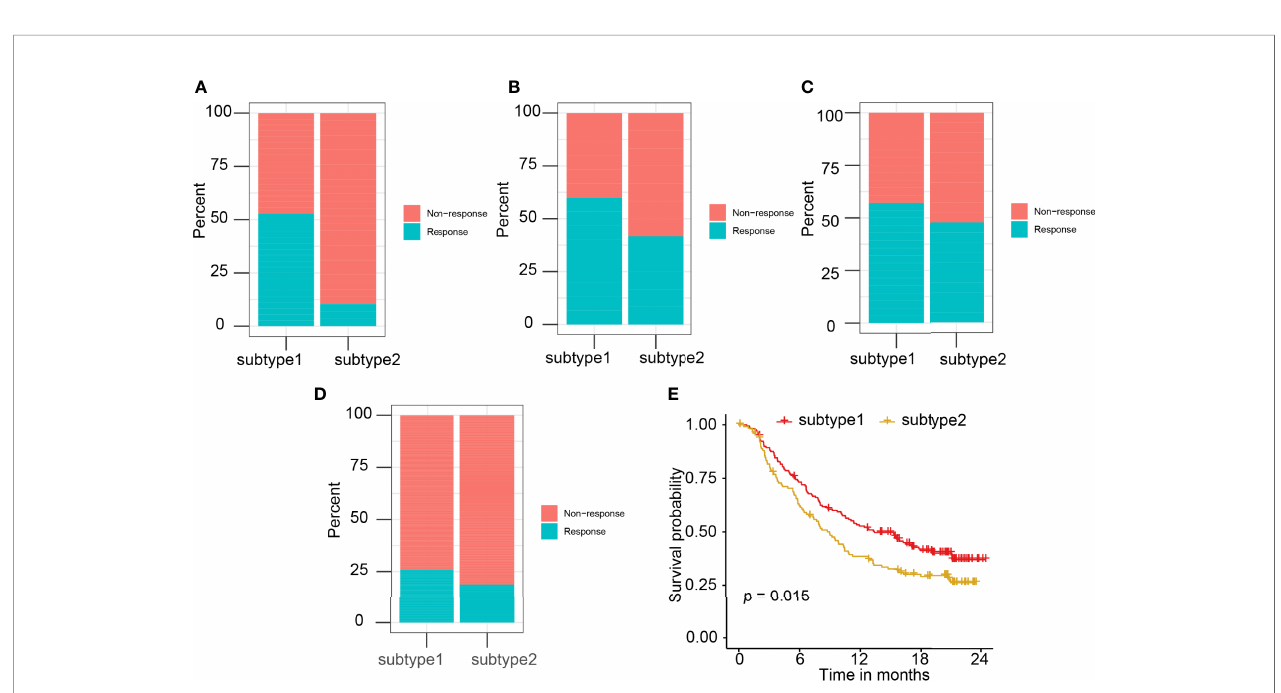
FIGURE 8 | The correlation of predicted immune subtype with the immunotherapy ef fi cacy in the independent datasets. (A – D) The correlation of predicted immune subtype with the response rate to immunotherapy in the independent datasets: (A) GSE35640, (B) GSE78220, (C) GSE91061, and (D) IMvigor210. (E) The correlation of predicted immune subtype with the survival analysis in the IMvigor210